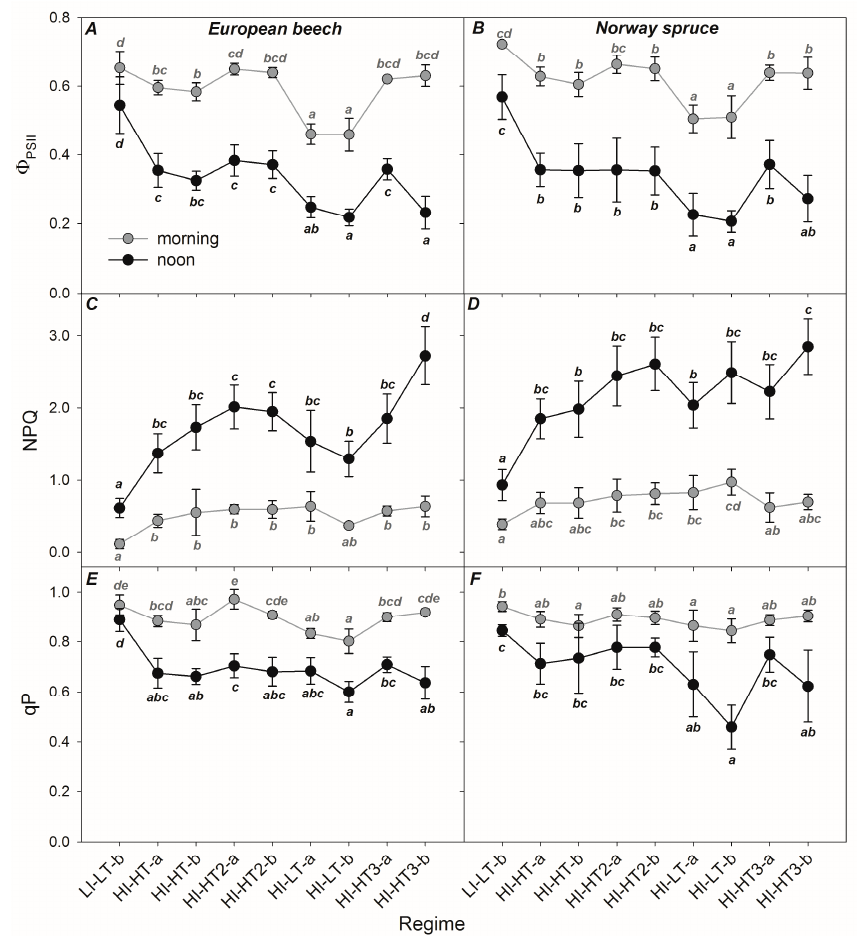
Figure 5. Changes in actual quantum yield of photosystem II photochemistry ( Φ PSII , ( A , B )), non-photochemical fluorescence quenching (NPQ, ( C , D )), and photochemical fluorescence quenching (qP, ( E , F )) in response to five consecutive regimes of photosynthetically active radiation (PAR) intensity and temperature (LI–LT, HI–HT, HI–HT2, HI–LT, and HI–HT3). Lowercase letters in the regime labels indicate data from measurements at the beginning (a) and end (b) of acclimation to the given regime. Data from morning (grey lines and points) and noon (black lines and points) measurements are shown. Means (points) and standard deviations (error bars) of the measurements are presented ( n = 6). Letters indicate homogeneous groups ( p < 0.05; Tukey’s post hoc test) separately for morning and noon measurements. Different letters represent statistically significant differences between the means.